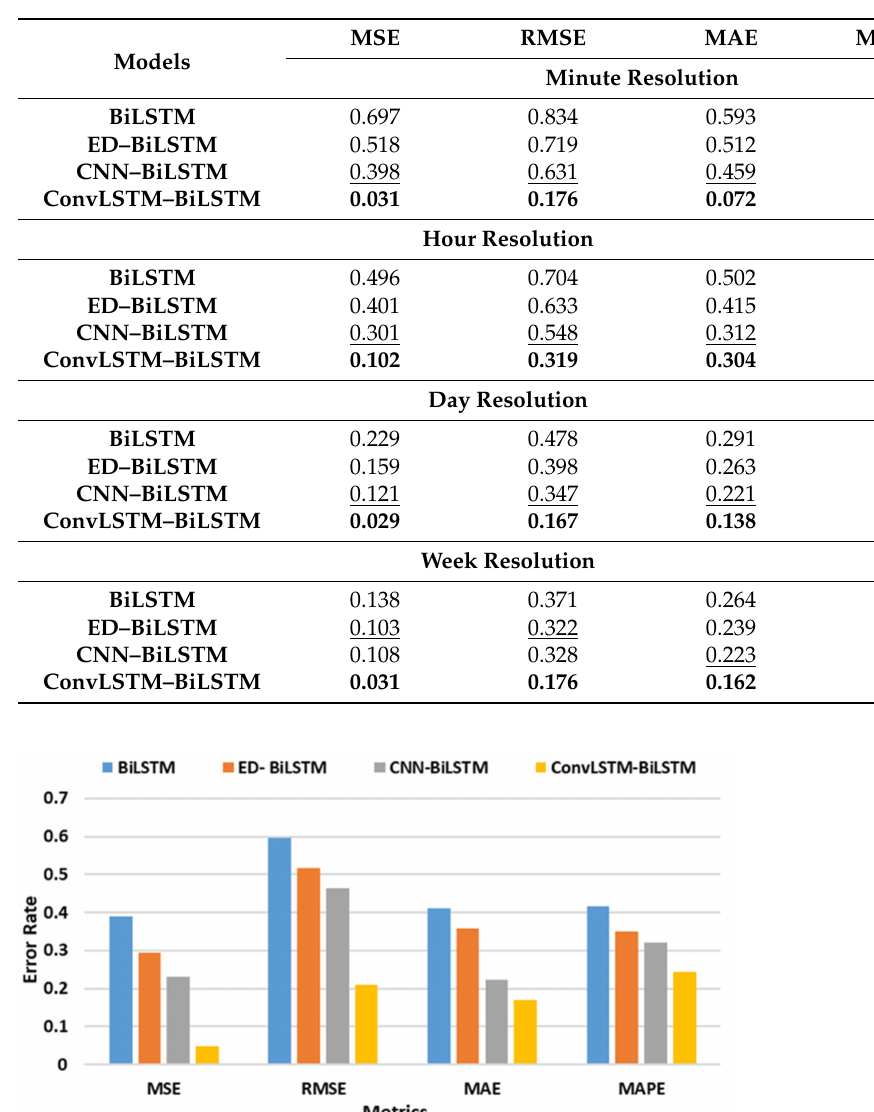
Table 7. Performance of the proposed models using cross-validation method for various data resolutions.